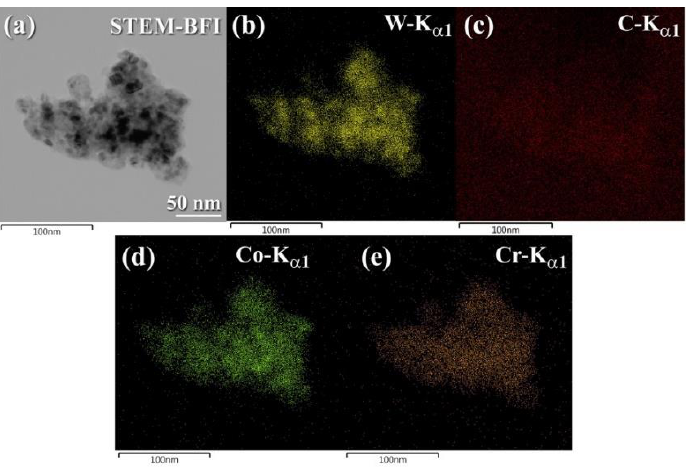
Figure 23. ( a ) STEM-BFI of WC nanocrystalline powders obtained after 20 h of the milling time and then ball milled with 7 wt. % (10Co/4Cr) powders for 50 h, using a high energy ball mill. The corresponding X-ray elemental mapping of W-Kα 1 , C-Kα 1 , Co-Kα 1 , and Cr-Kα 1 are displayed in ( b ), ( c ), ( d ) and ( e ), respectively.